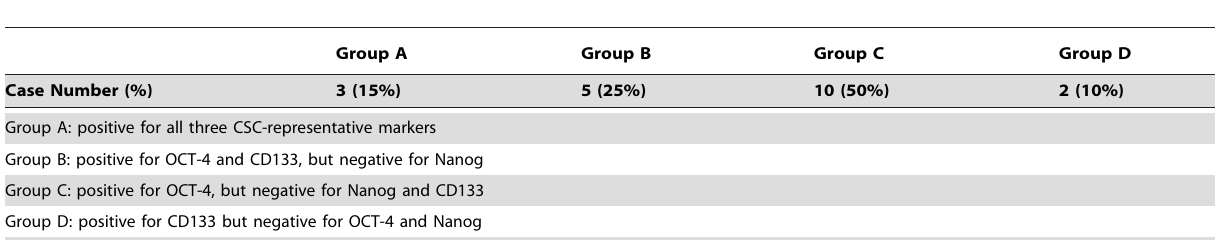
Table 2. Classification of immunoexpressions of three CSC-representative markers and their combinations into four groups showing variable corresponding numbers and proportions in 20 patients with MPE.